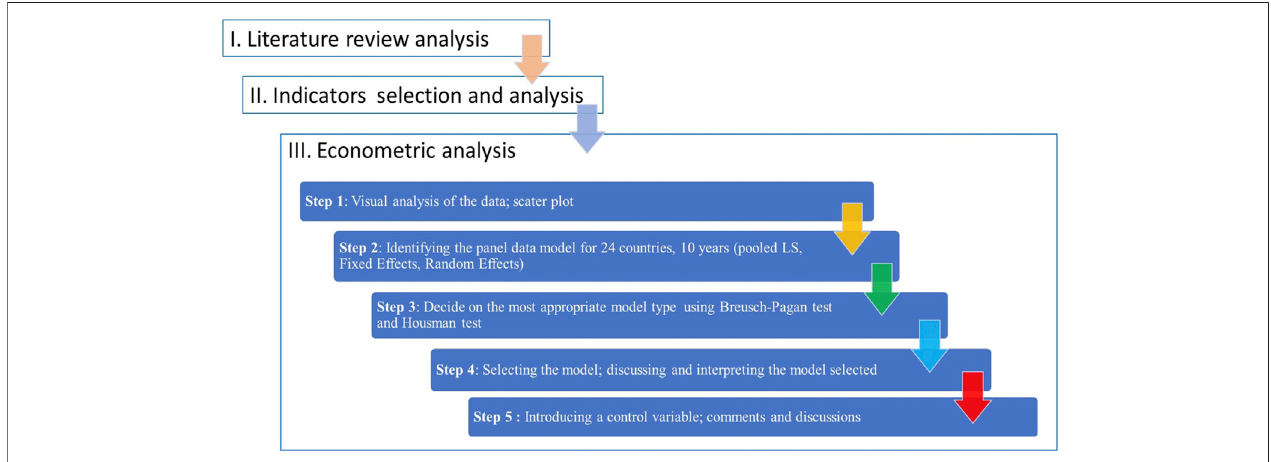
FIGURE 2 | Methodology used for modeling e-waste recycling and eco-investment in EU countries/Source: Own contribution.